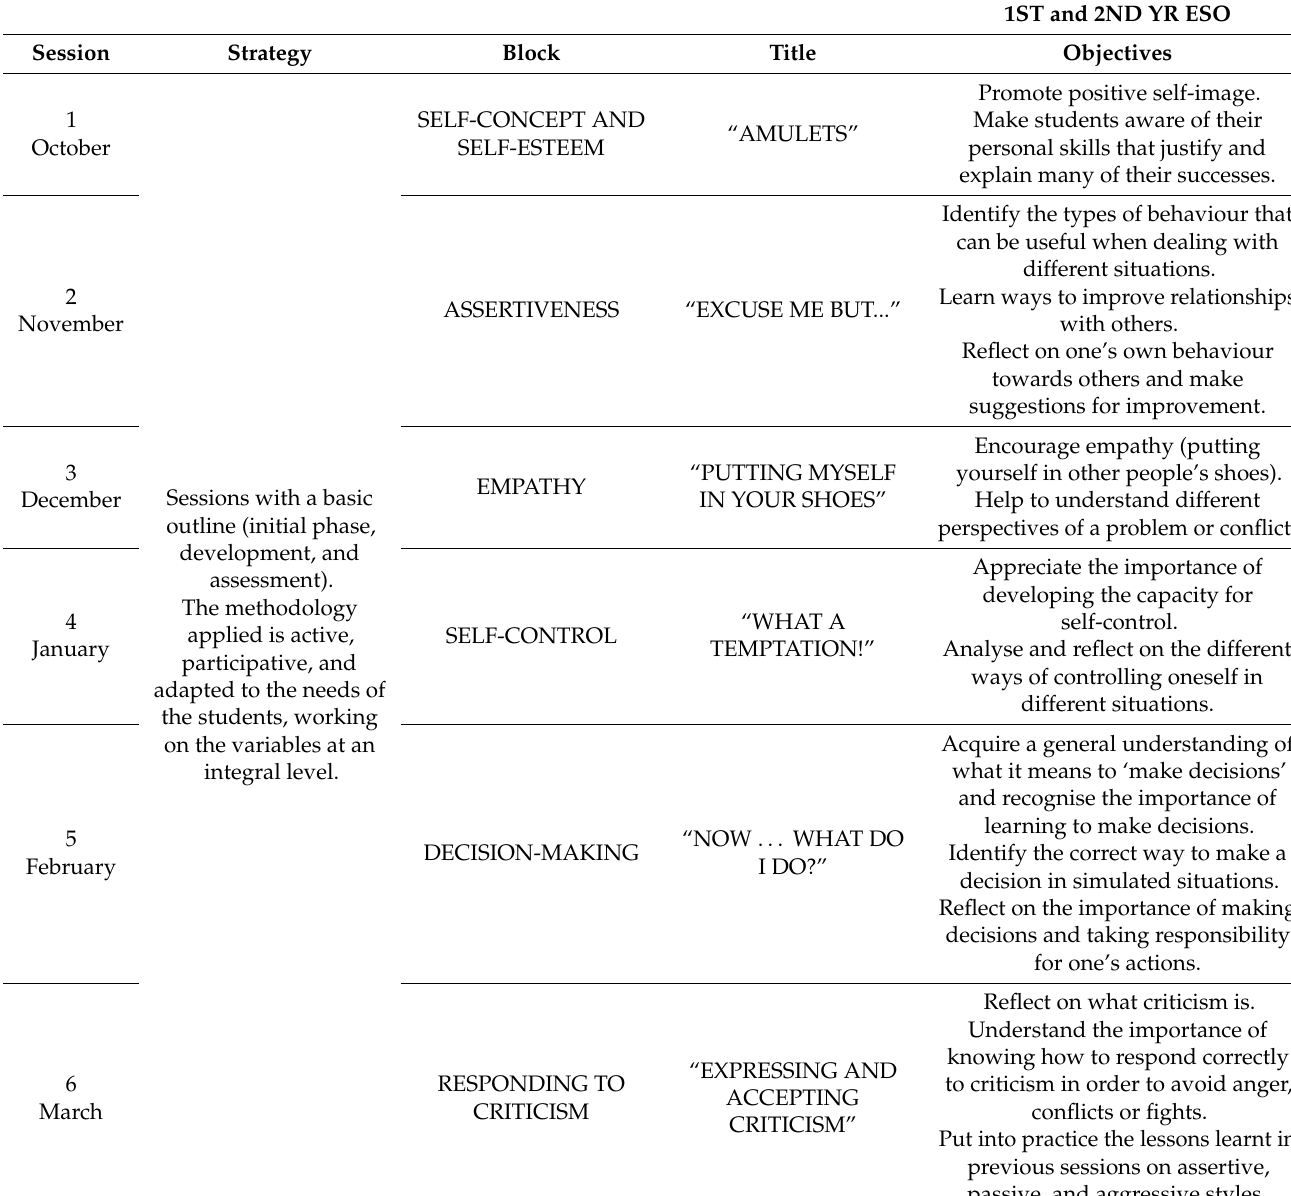
Table 1. Structure of the intervention programme for 1ST and 2ND YR